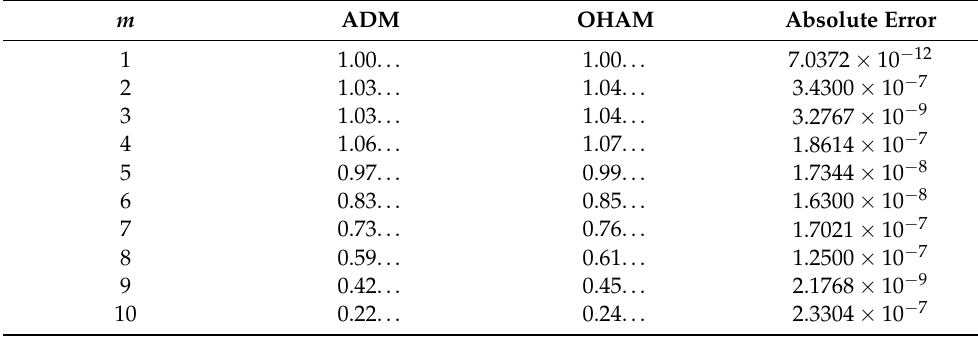
Figure 13. Influence of the magnetic field parameter on the temperature profile. Table 1. OHAM and analytical comparison for f ( η )